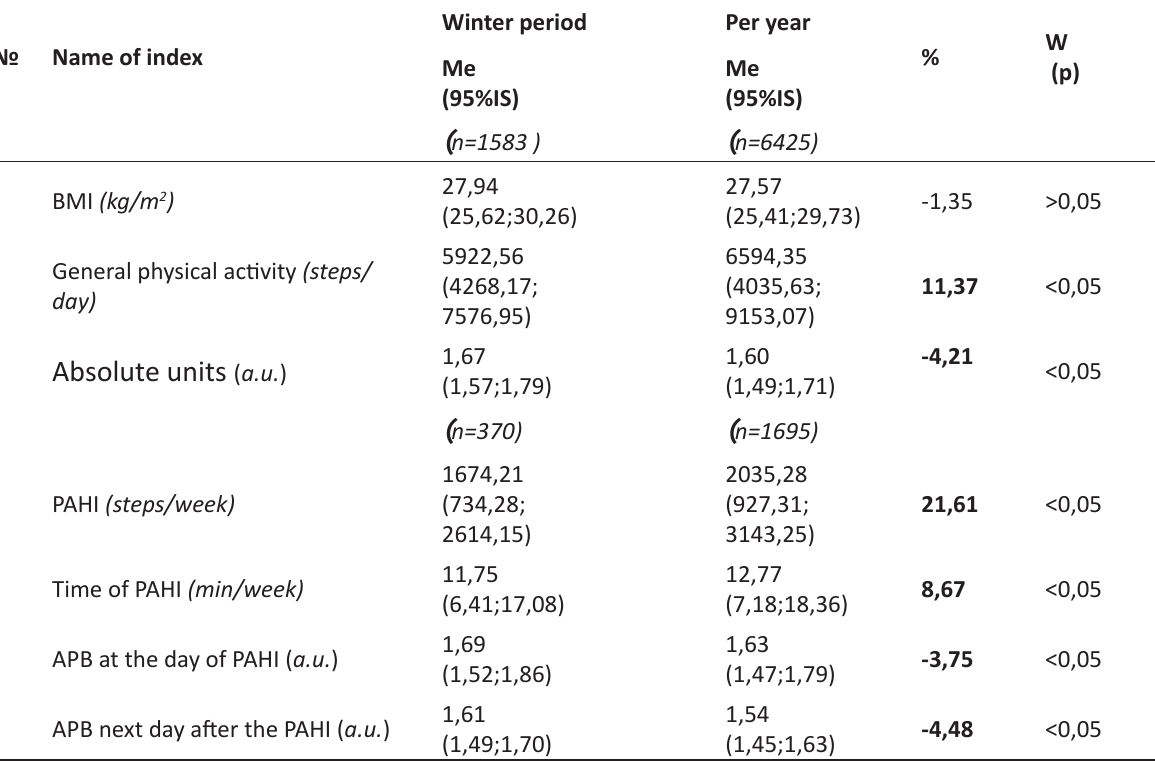
Table 1. Comparison of indicators of physical condition and physical activity of men in winter